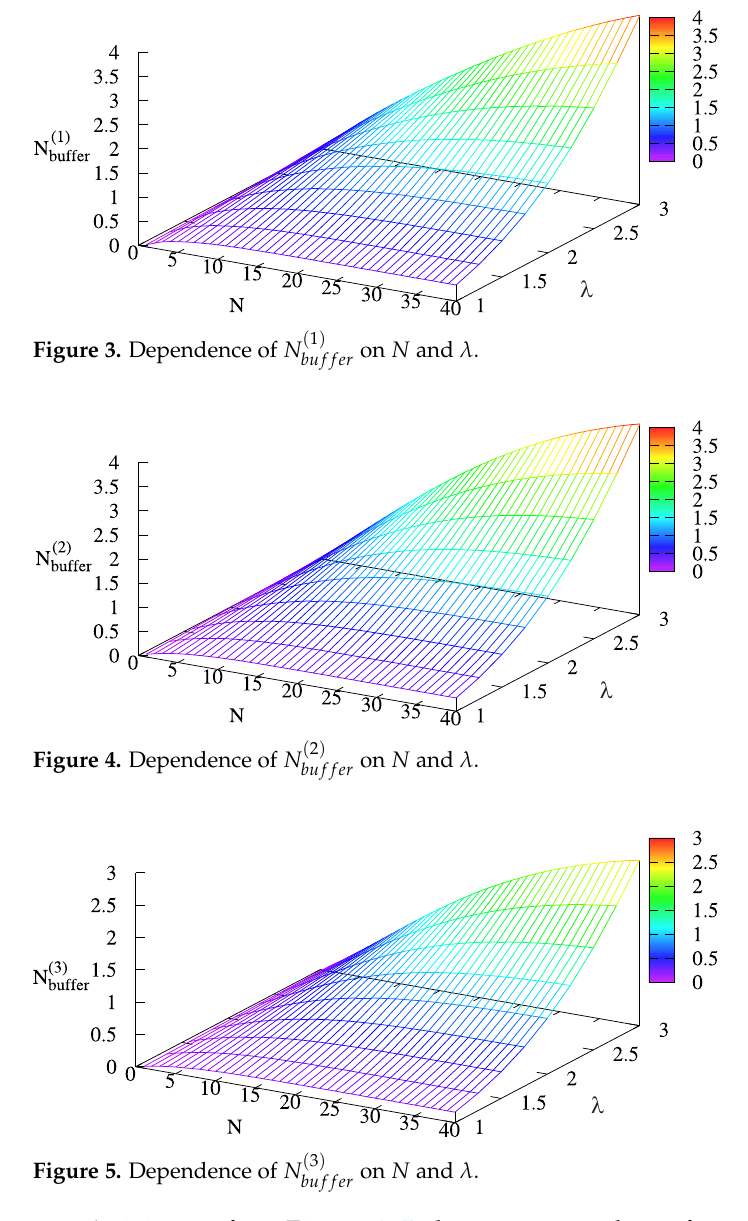
Figure 5. Dependence of N